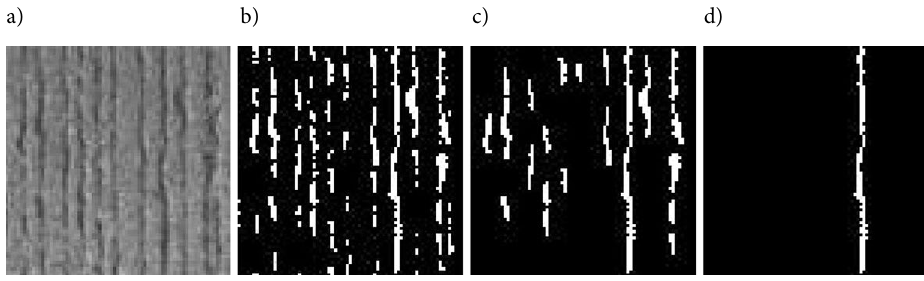
Figure 7. Example of non-crack pavement block with strong longitudinal tined texture (from left to right): a – raw crack block; b – local filtering; c – minor removal; d – maximum extraction